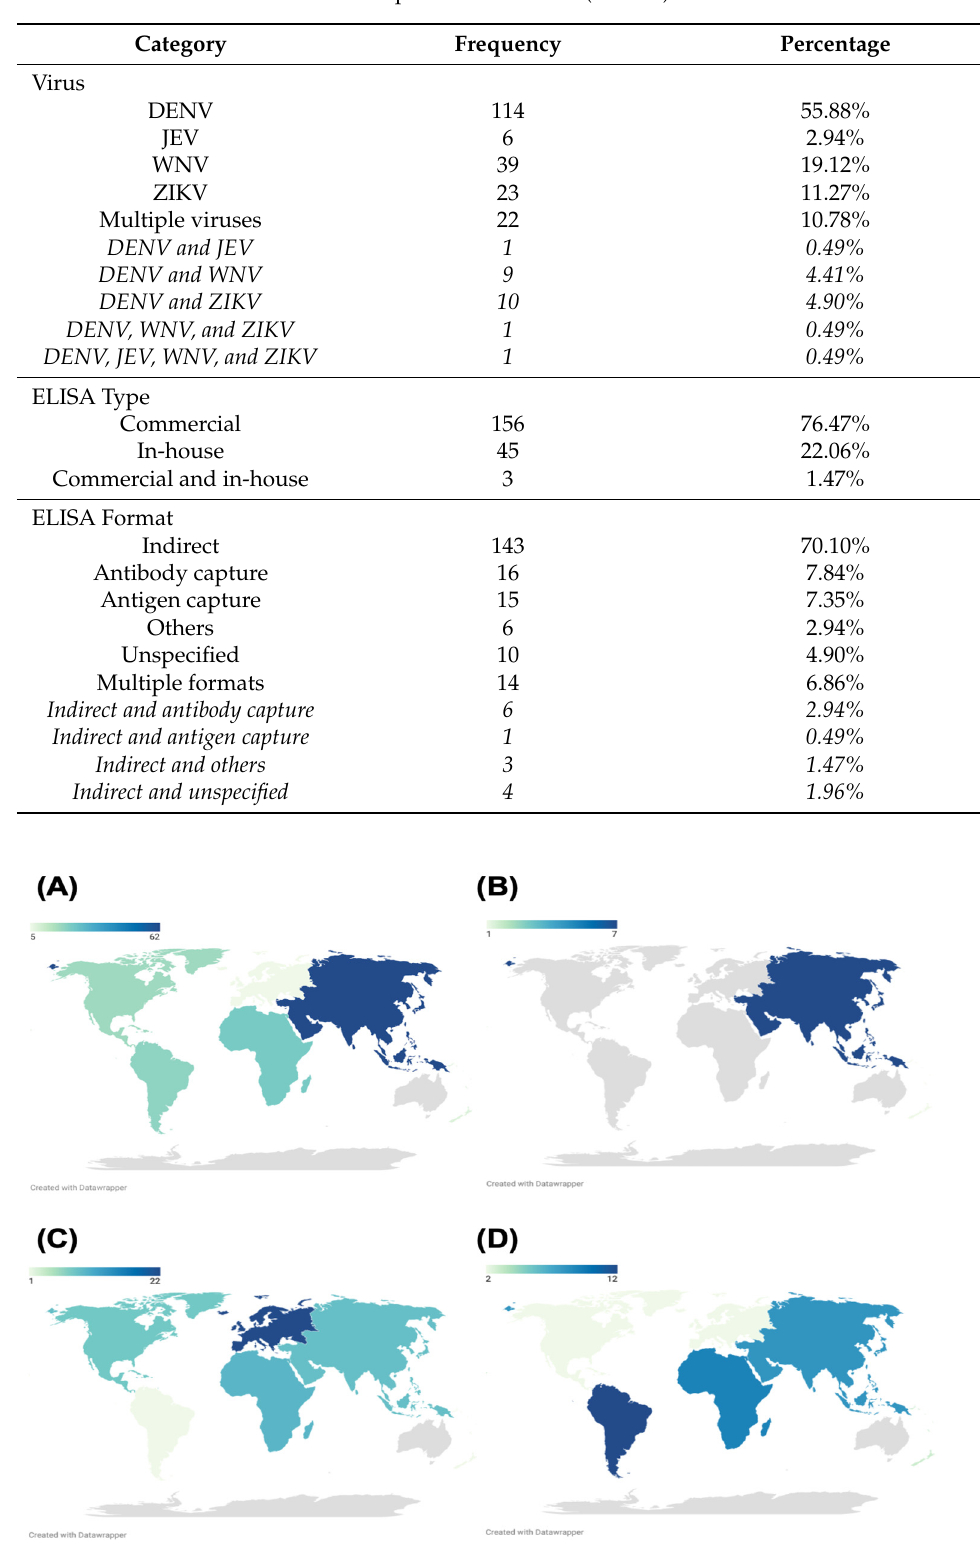
Table 1. Distribution of flavivirus seroprevalence studies ( n = 204).